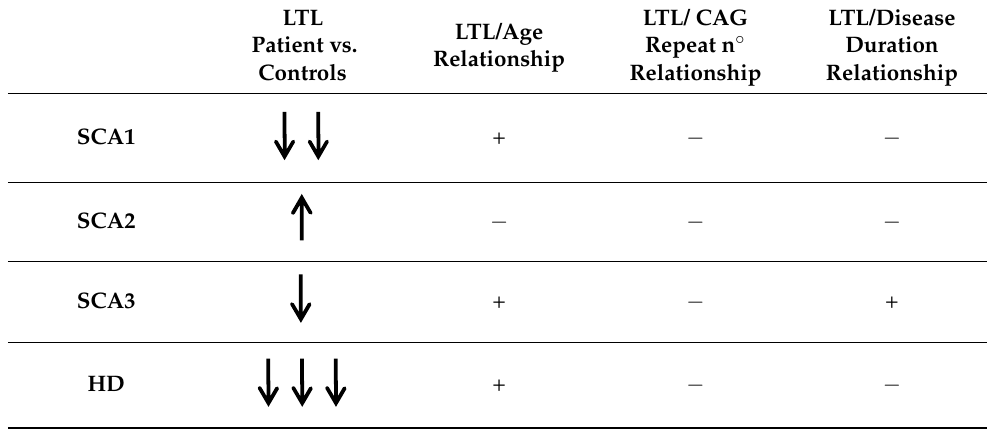
Table 3. Summary of the LTL trends and their relationships in SCA1, SCA2, SCA3, and HD. Summary of the LTL trends (patients vs. controls) in SCA1, SCA2, SCA3, and HD [31], and their relationships with age, CAG repeat number, and disease duration. The symbol of the arrows indicates the decrease and the increase in LTL, +/ − indicate the presence/absence of the relationship.